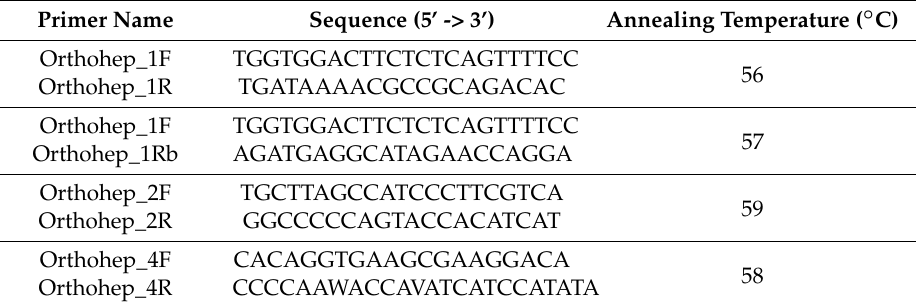
Table 2. Primers designed for sequencing and quantification of Taï Forest